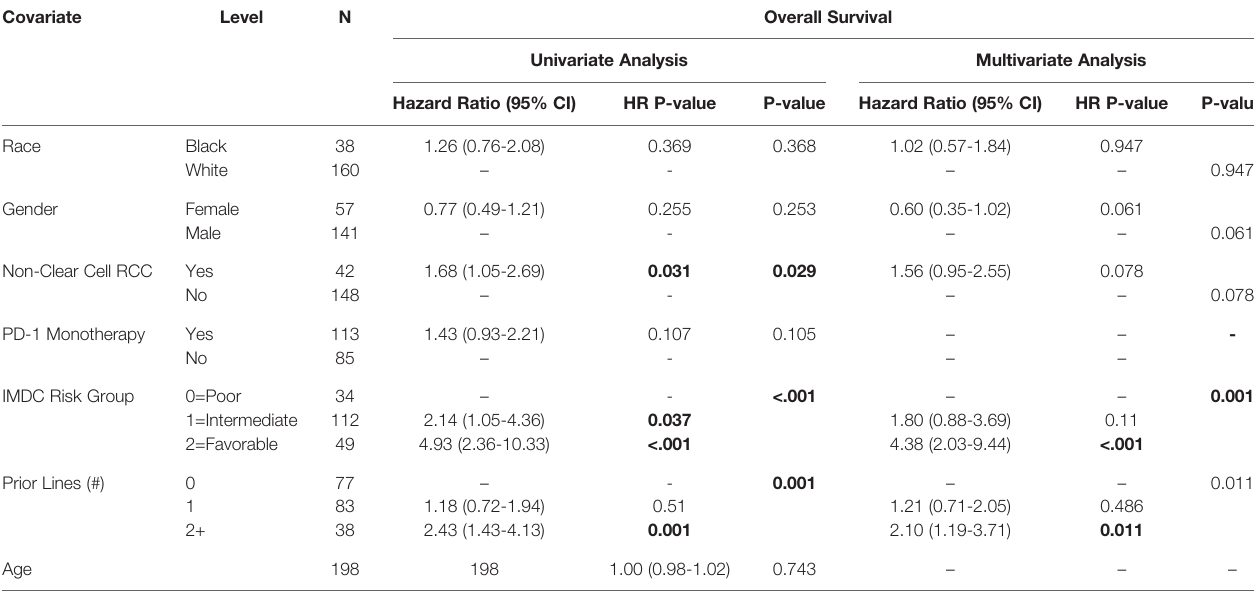
*The p-value is calculated by ANOVA for numerical covariates; and chi-square test or Fisher ’ s exact for categorical covariates, where appropriate. IO,Immunotherapy;PD-L1,Programmeddeath-ligand1;RCC,renalcellcarcinoma;CC,clearcell;NCC,non-clearcell;IMDC,InternationalMetastaticRCCDatabaseConsortium;ECOG PS, Eastern Cooperative Oncology Groups Performance Status. Bold denotes statistical signi fi